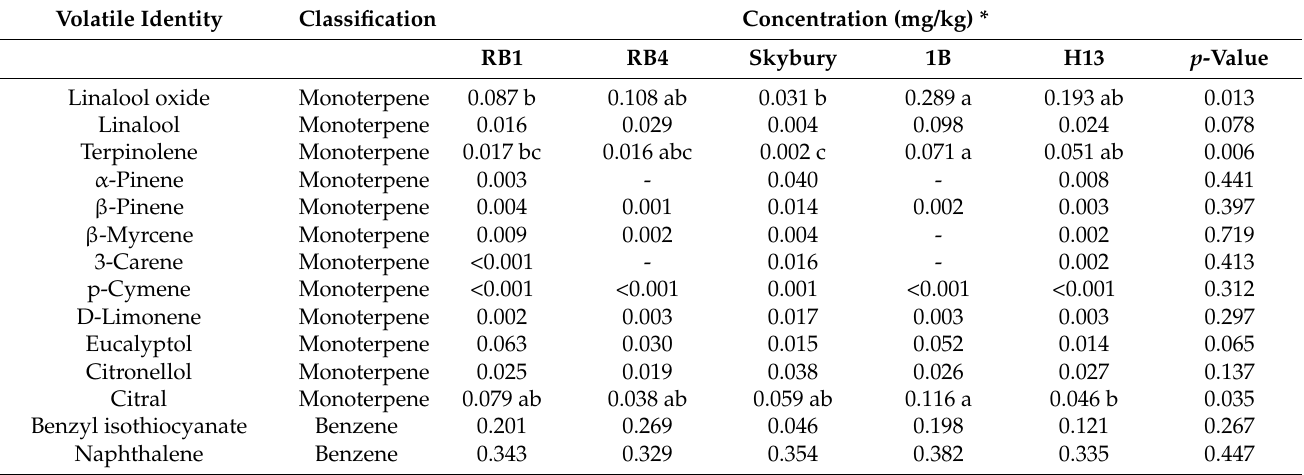
Table 2. Concentrations of identified volatiles in five papaya varieties after GCMS